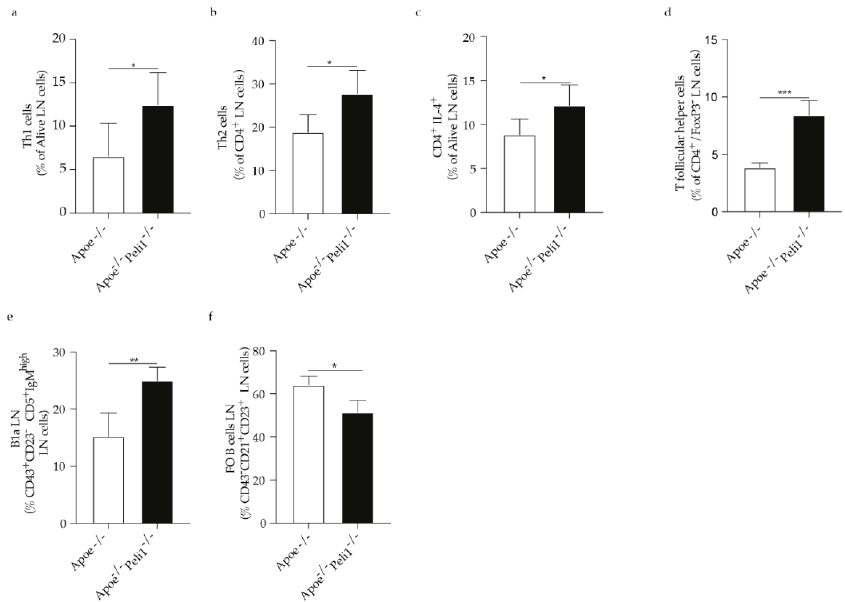
Figure 4. Bar graphs represent the quantification of lymph node (LN) ( a ) Th1 cells; ( b ) Th2 cells; ( c ) CD4 IL-4 cells; ( d) T follicular helper cells; ( e ) B1a cells and ( f ) FO B cells in Apoe −/− and Apoe −/− Peli1 −/− mice on HCD, n = 7 – 8/group. U-Mann Whiney, all data are presented as median with interquartile range with p ≤ 0.05 *; p ≤ 0.01 ** and p ≤ 0.001 ***.